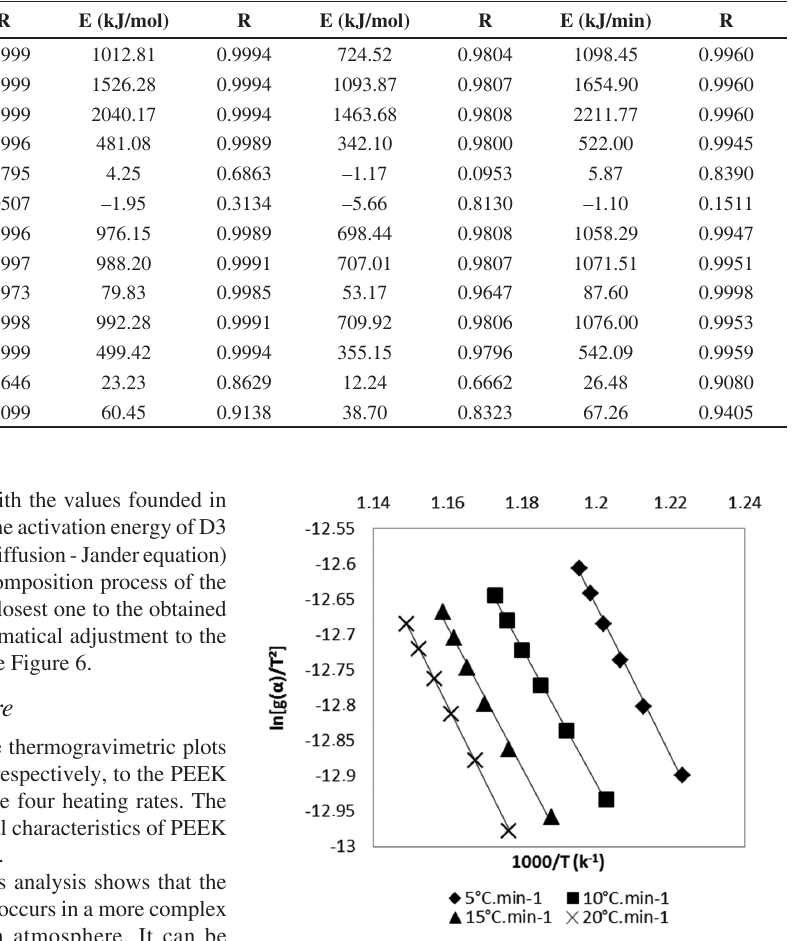
Table 3. Activation energies for the heating rates of 5 °C.min –1 ; 10 °C.min –1 ; 15 °C.min –1 and 20 °C.min –1 in nitrogen atmosphere. Mechanism